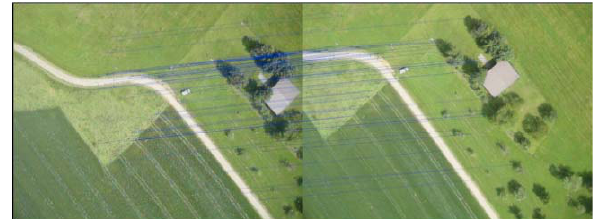
Figure 9: Matching result of UAVMatcher.